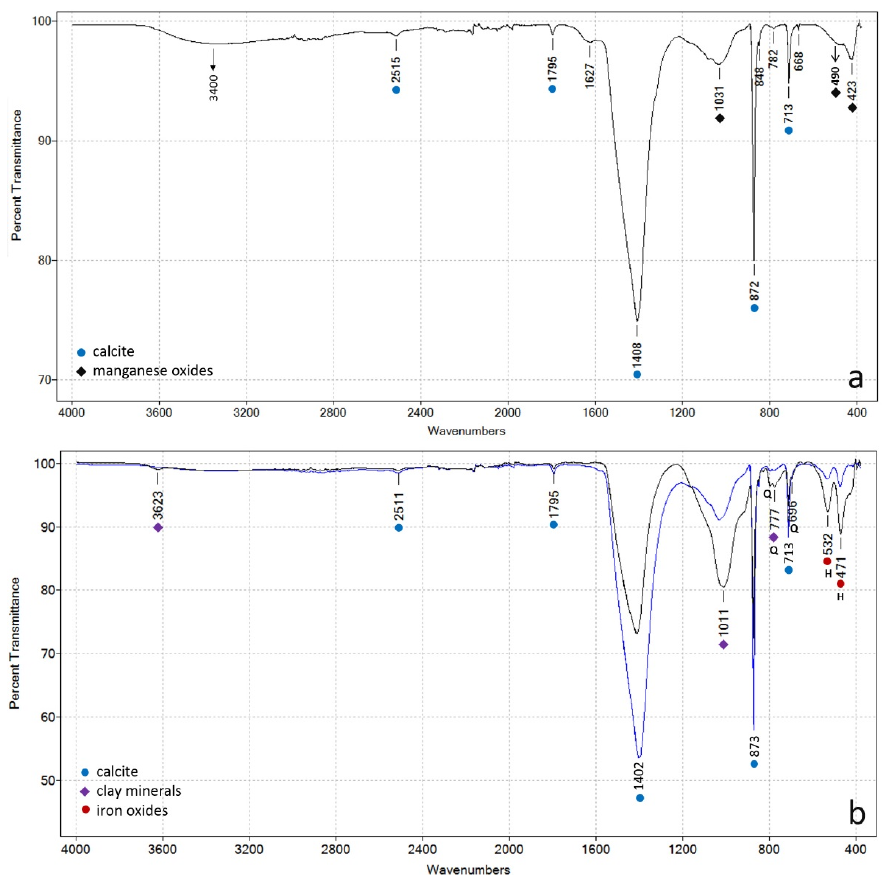
Figure 4. FTIR spectrum registered on the black finishing layer (sample S7) ( a ) and on the plaster layers ( b ) (coarse plaster layer with black line; fine plaster layer with blue line). The absorptions of the various mineral components identified are marked on the spectra as follows: Q—quartz;